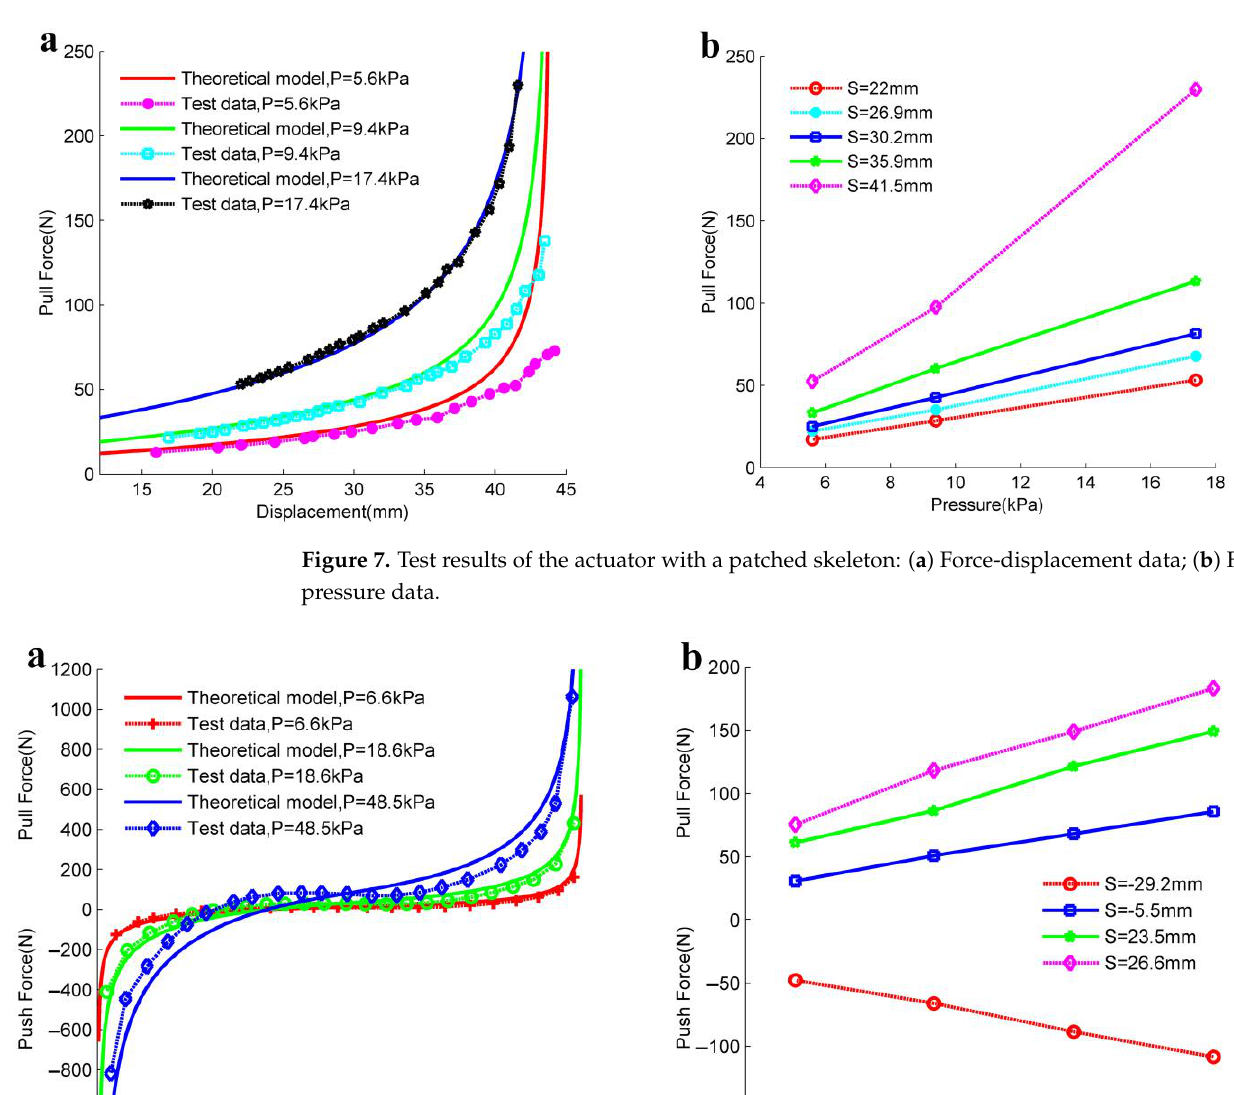
Figure 9. Test results of the PET-beamed actuator with a 3D-printed skeleton: ( a ) Force-displace- ment data; ( b ) Force-pressure data.